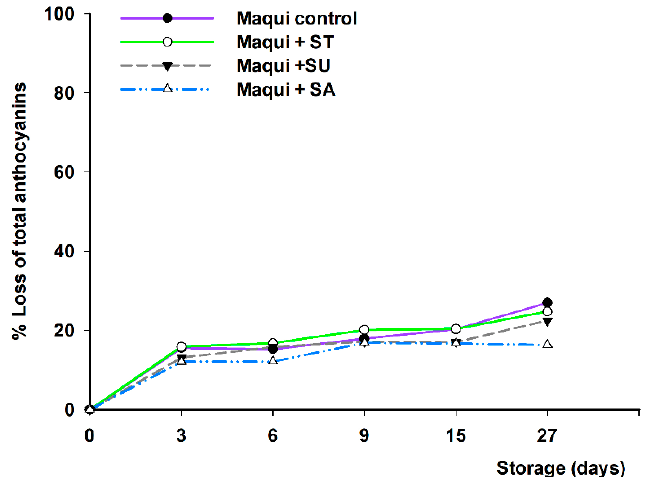
Figure 4. Percentage of loss of total anthocyanins in maqui-berry beverage samples (control without sweeteners) and maqui-berry beverage samples plus sweeteners, stevia (ST), sucralose (SU), and sucrose (SA), measured during storage for 27 days at 4 °C. Significantly different final concentration absolute values according to statistical analysis (ANOVA and Tukey’s multiple rank test) were found at p < 0.01.